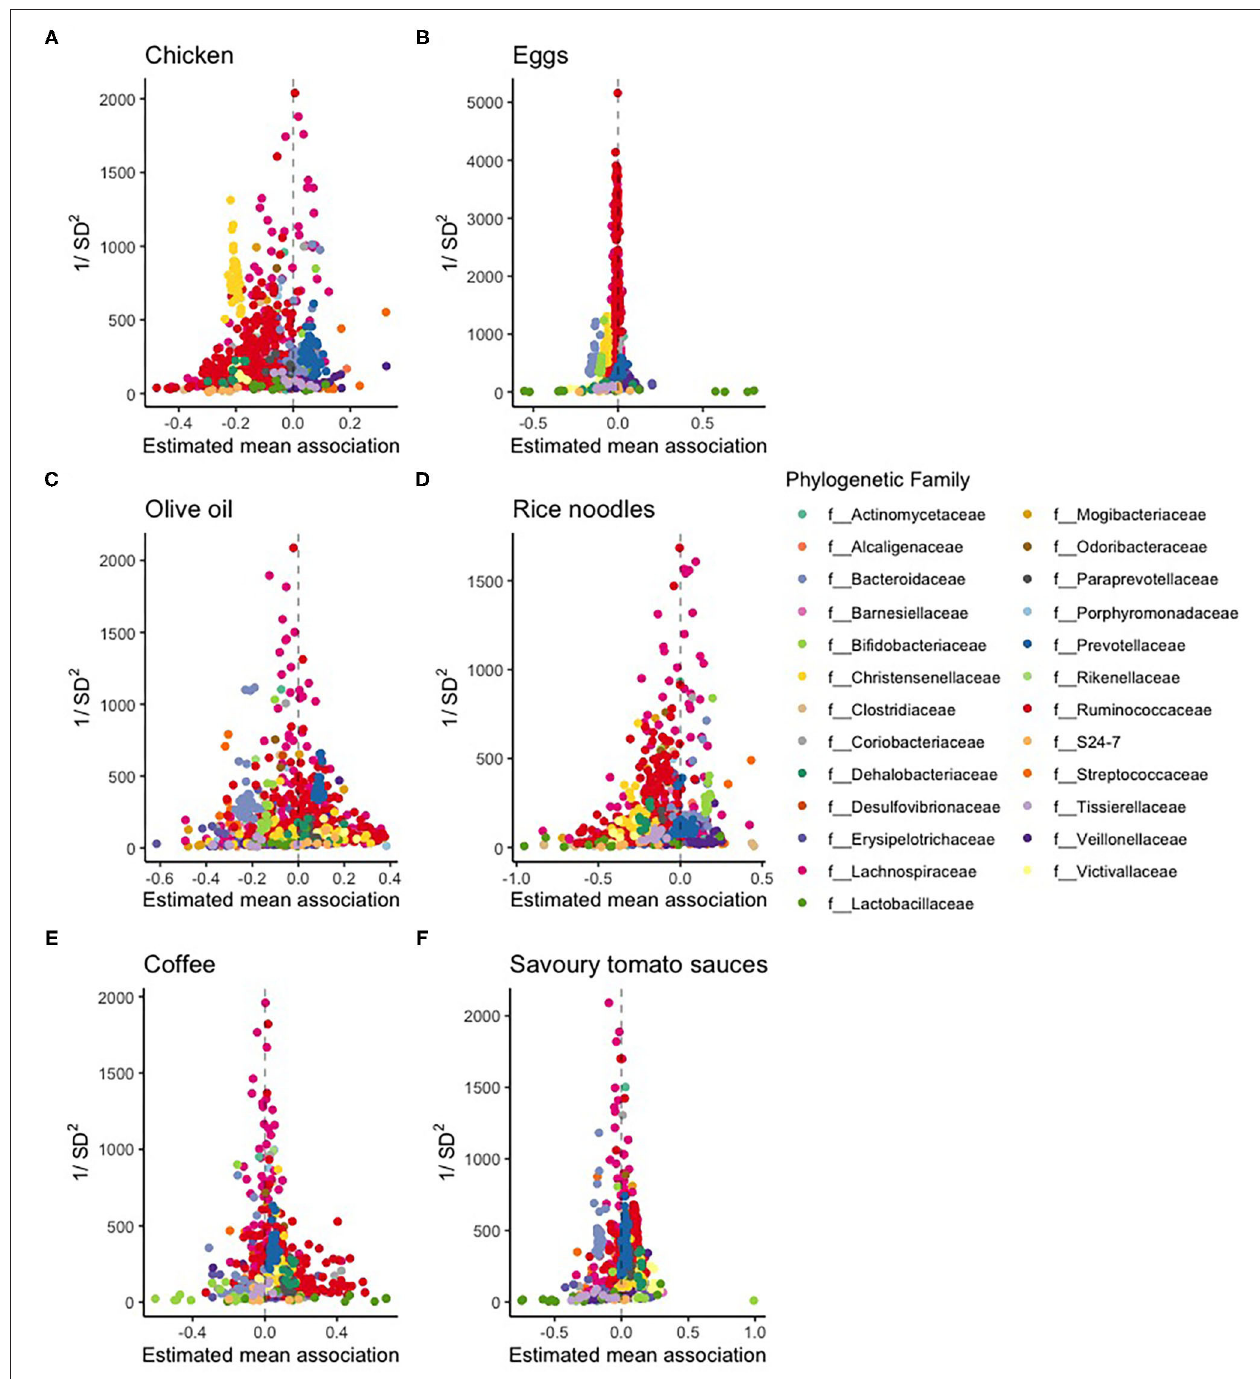
FIGURE 4 | Volcano plots of the diet-microbe associations between the FFQ scores of (A) chicken, (B) eggs, (C) olive oil, (D) rice noodles, (E) coffee, and (F) savory tomato sauces.